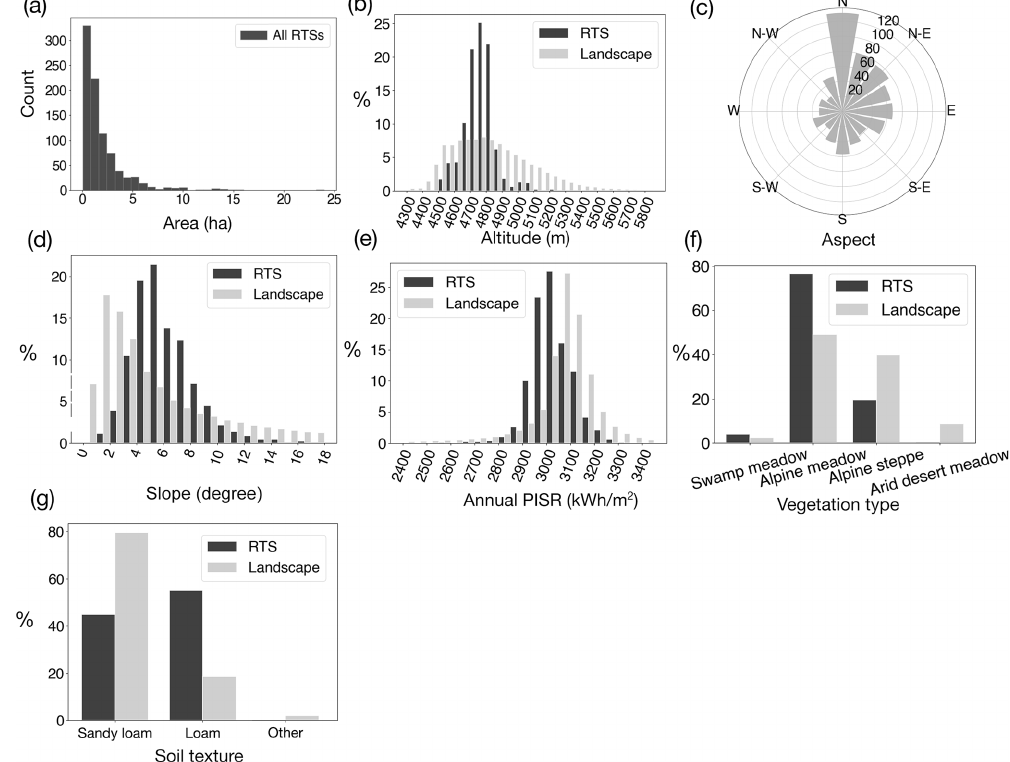
Figure 6. Statistical summaries of the RTSs’ geometric features and terrain properties. (a) The histogram shows the area of all the RTSs in the research region. (b) The elevation frequency of the landscape and RTSs. Landscape means the entire study region. (c) The slope aspects of RTSs, with the radial axis representing the number of RTSs. (d) The slope frequencies of the landscape and RTSs. (e) The annual PISR frequencies of the landscape and RTSs. (f) The vegetation type distribution of the landscape and RTSs. (g) The soil texture distribution of the landscape and RTSs.